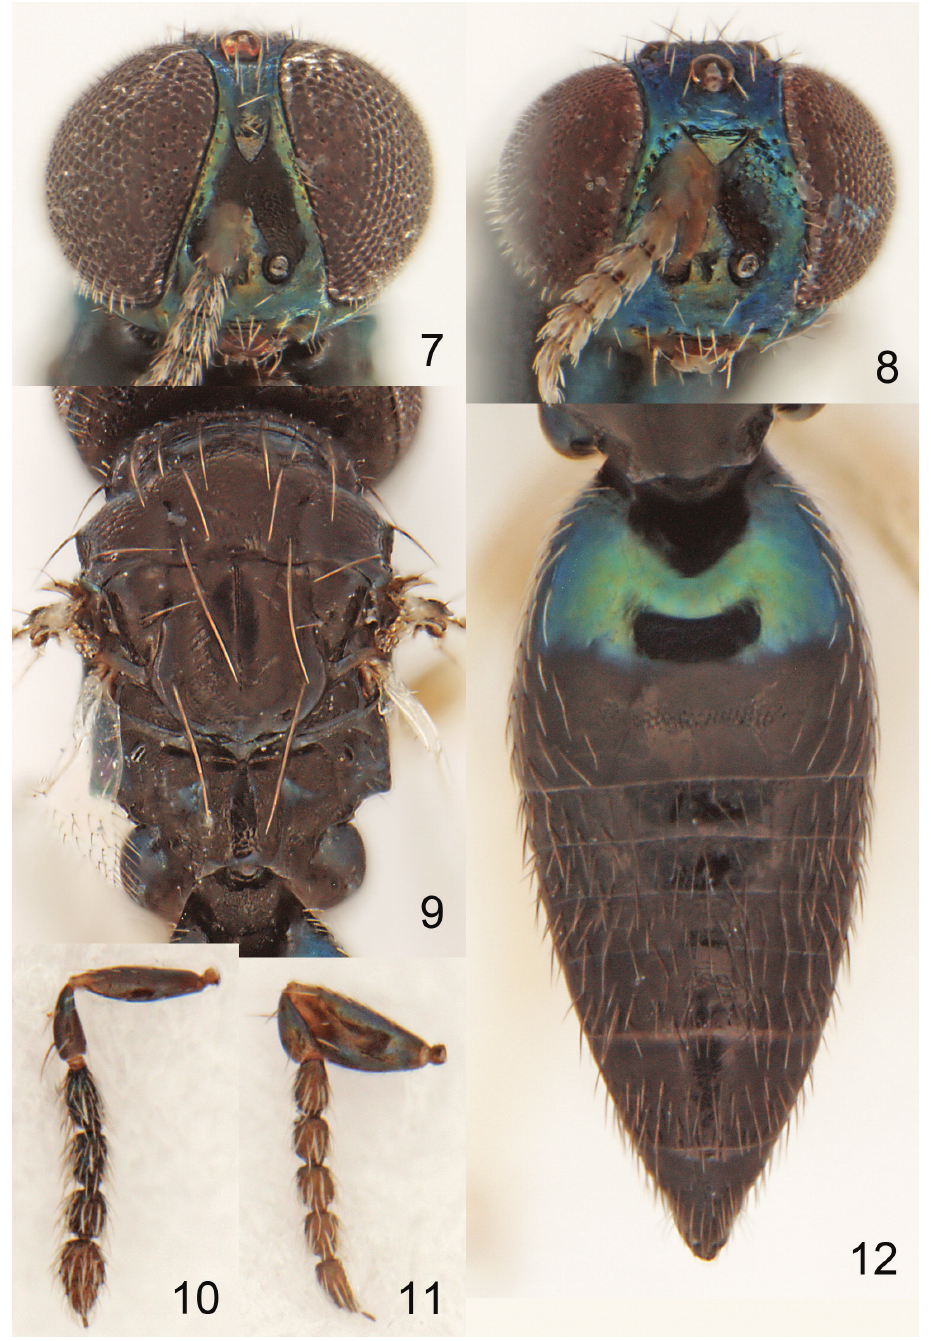
Figures 7–12. Horismenus liturgusae sp. n. 7 Head frontal, female 8 Head frontal, male 9 Mesosoma dorsal, female 10 Antenna lateral, female 11 Antenna lateral, male 12 Gaster dorsal,